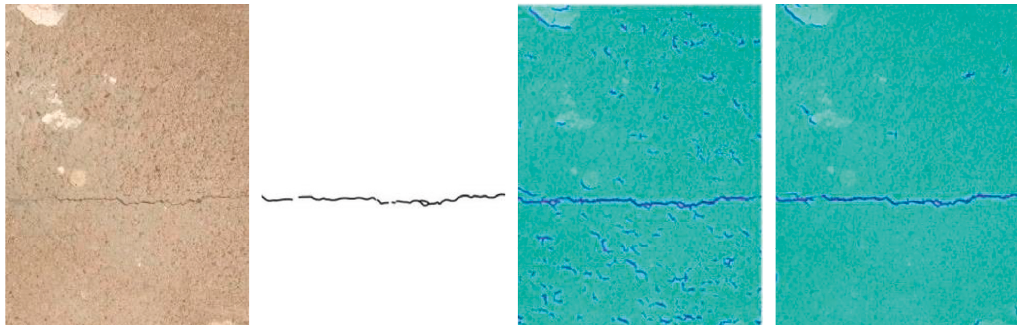
Figure 8: FCN-8s and new network coagulation rough surface inspection results.